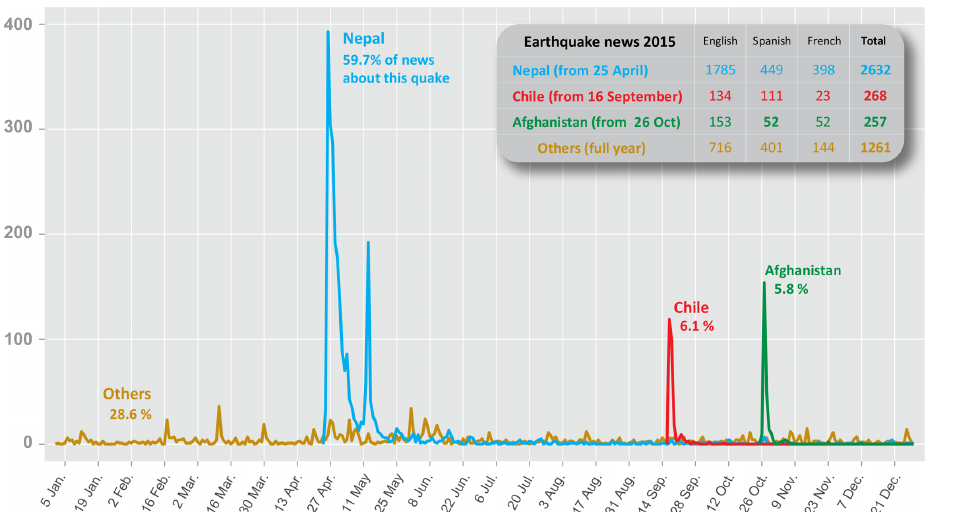
Figure 3. The media coverage intensity (number of news items published per day) for the year 2015 is dominated by three events: the Nepal quake, an earthquake in the area of Ilapel, Chile, and an earthquake in the Hindu Kush region, Afghanistan.